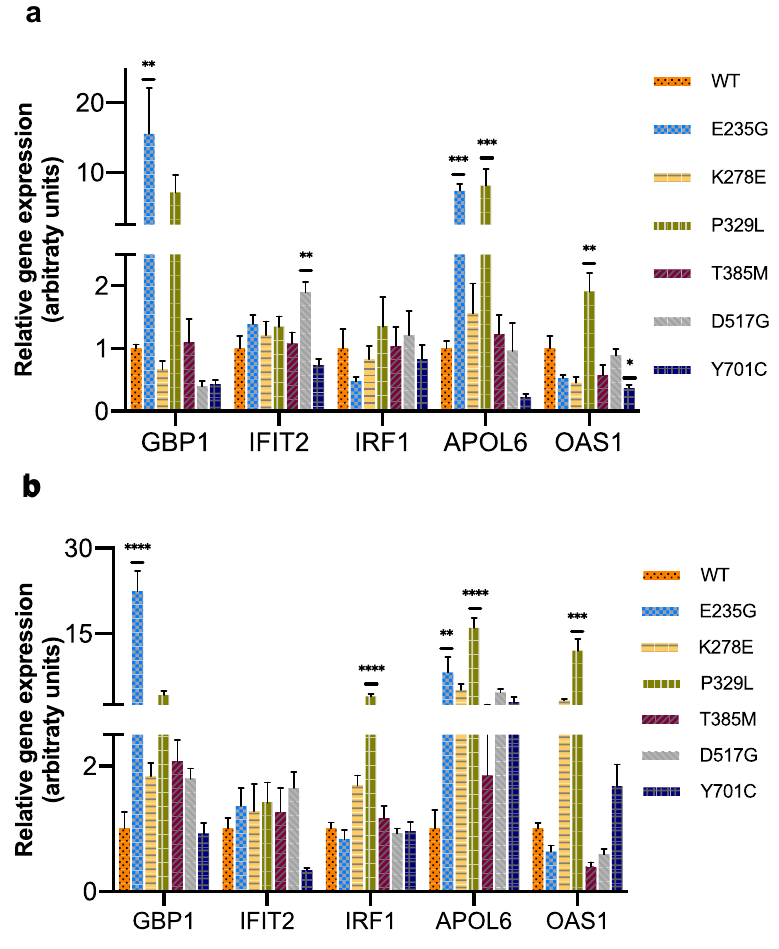
Fig. 3 Relative gene expression of interferon-stimulated genes (ISG) at baseline and following serum starvation. a mRNA expression levels were measured for fi ve ISG ( GBP1, IFIT2, IRF1, APOL6, OAS1 ) at baseline in cells grown under normal serum conditions; b mRNA expression levels for fi ve ISG measured in cells following 24-h of serum starvation. Expression levels were normalized to housekeeping GAPDH expression and plotted relatively to wild type for each experiment. Pooled data from at least fi ve experiments are presented. Data are represented as mean ± standard error of mean. Statistical analysis: one-way ANOVA with Dunnett ’ s post hoc test (* p < 0.05, ** p < 0.01, *** p < 0.001, **** p <